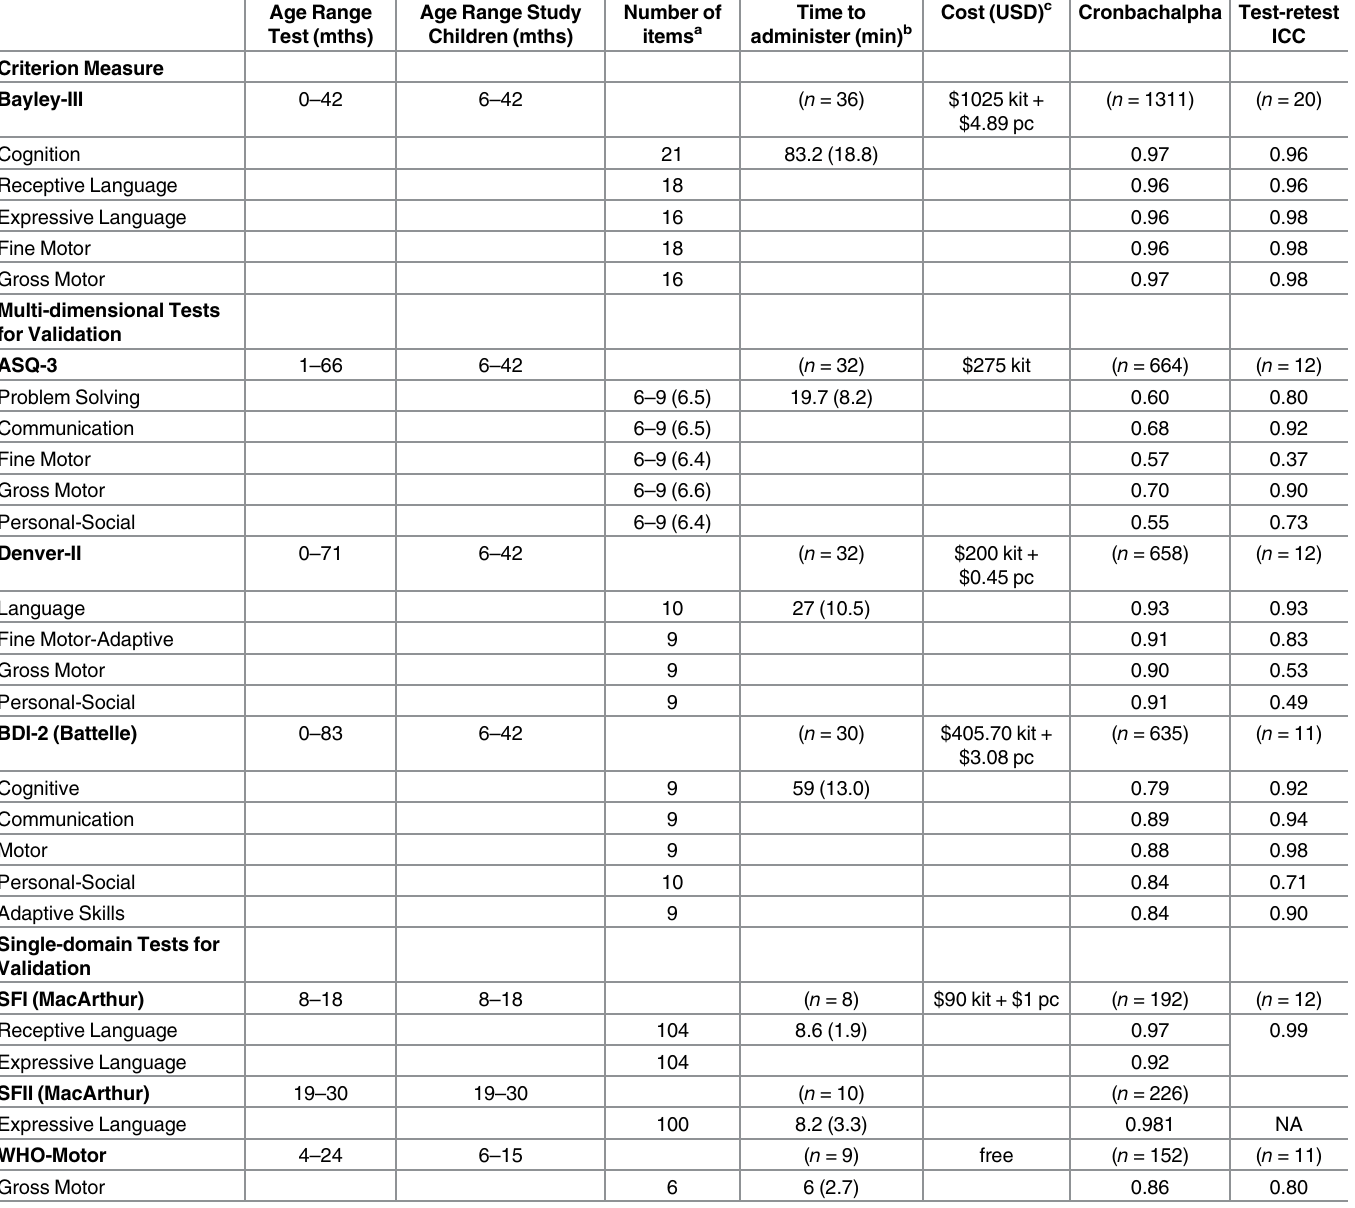
Table 1. Characteristics of the Bayley-III and the Short